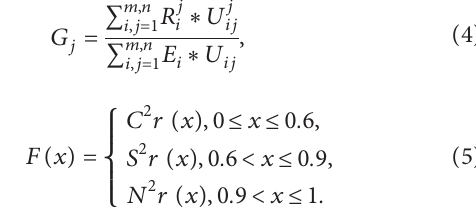
Figure 1: HR IoT